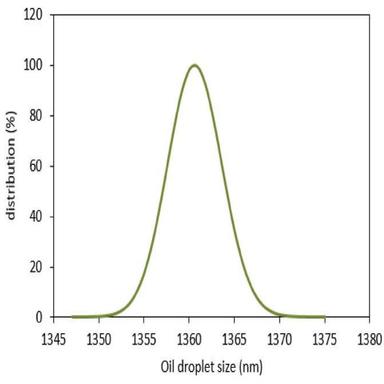
Droplet size distribution of oil in the emulsion.